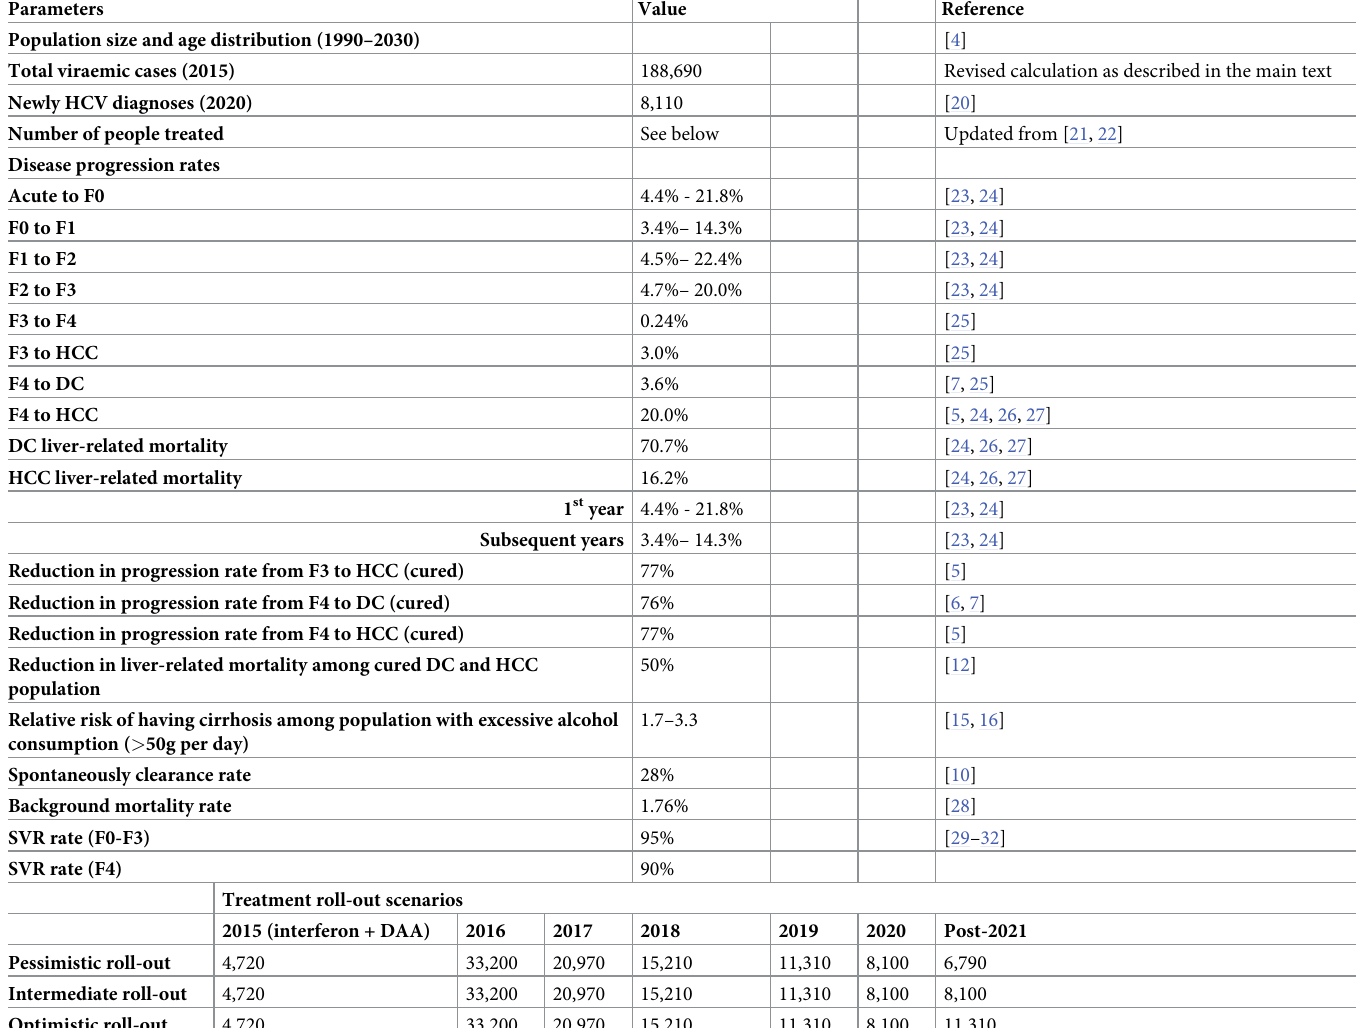
Table 1. Model inputs and parameter